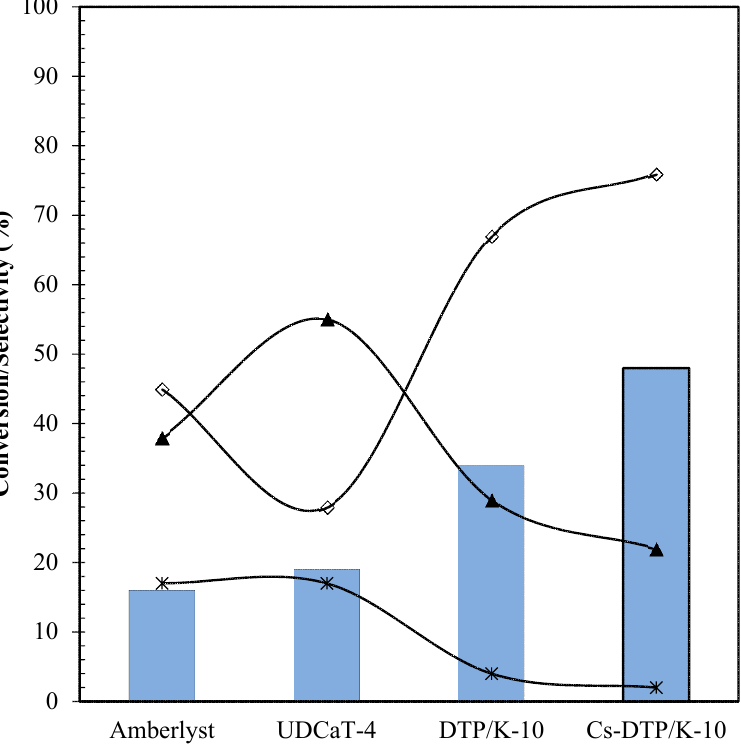
Figure 1. Efficacy of different catalysts. Temperature: 150 °C. Catalyst loading: 0.03 g/cm 3 . Glyc- erol:BA mole ratio = 1:3, speed of agitation: 1000 rpm, reaction time: 4 h. ( ) MBGE; ( ) DBE; ( ) DBGE.